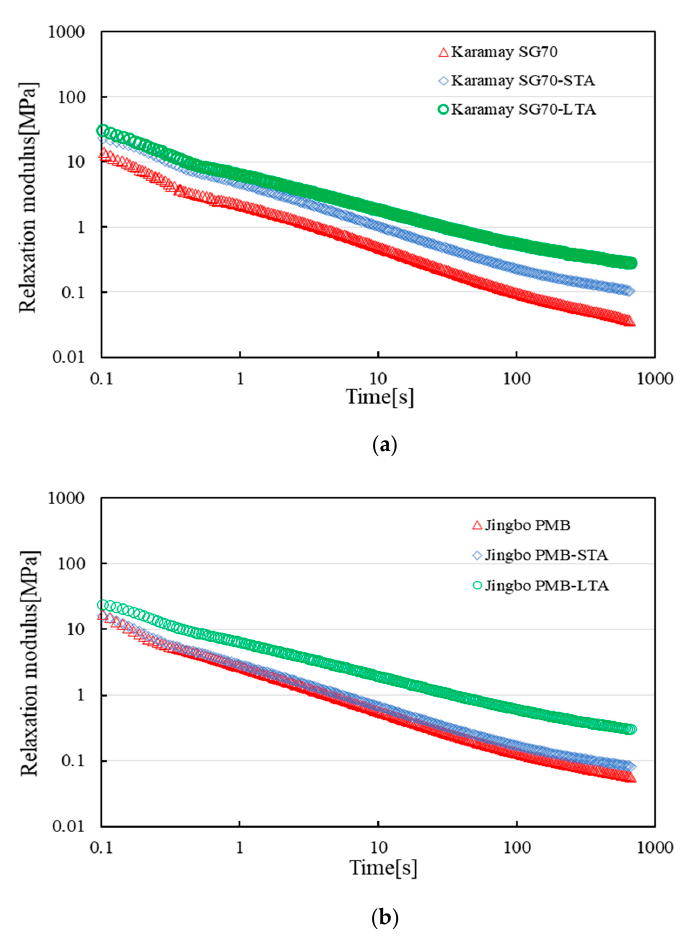
Figure 6. Development of a relaxation modulus over time for two types of bitumen binders at − 10 °C: ( a ) Karamay SG70 bitumen; ( b ) Jingbo PMB bitumen.